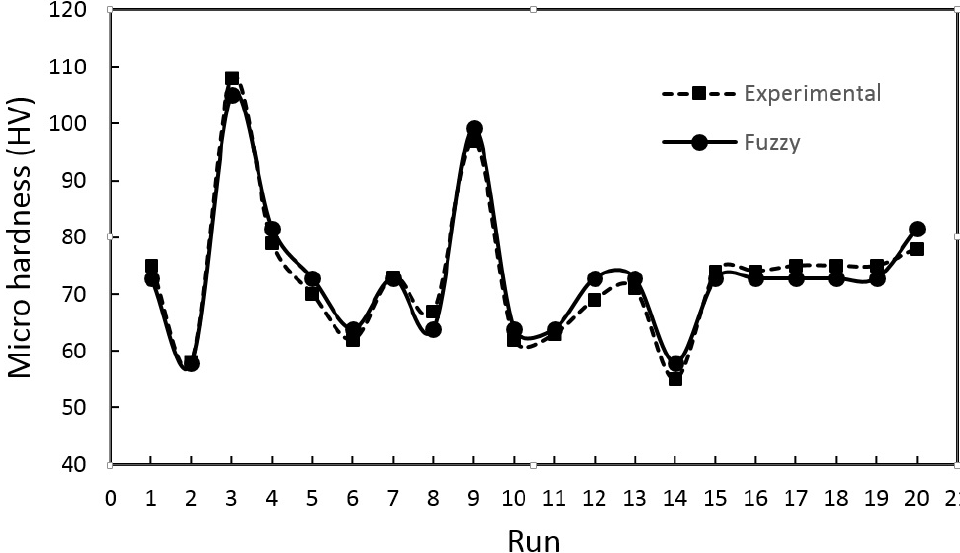
Figure 2. Micro-hardness and fuzzy micro-hardness results.